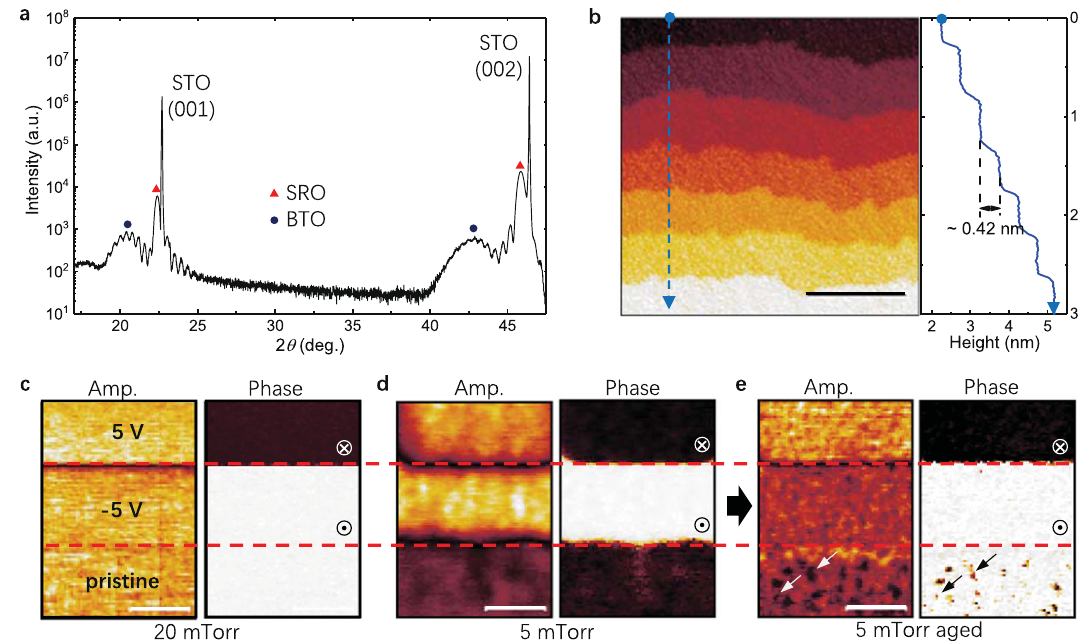
Fig. 1 BTO fi lm quality characterization and self-polarization examination. a θ -2 θ scan of X-ray diffraction (XRD) and b atomic force microscopy (AFM) morphology of a 5-BTO fi lm. The inset of ( b ) shows the height pro fi le along the marked line in the AFM image. The scale bar for the AFM image is 1 μ m. Piezoelectric force microscopy (PFM) images of a 20-BTO fi lm ( c ) and a fresh 5-BTO fi lm ( d ), with positively ( fi eld pointing from the fi lm surface to the bottom electrode) and negatively biased, as well as pristine regions. e The aged domain structure of the 5-BTO fi lm in air, with arrows indicating the locations of some nanodomains. The scale bar for all the PFM images is 1 μ